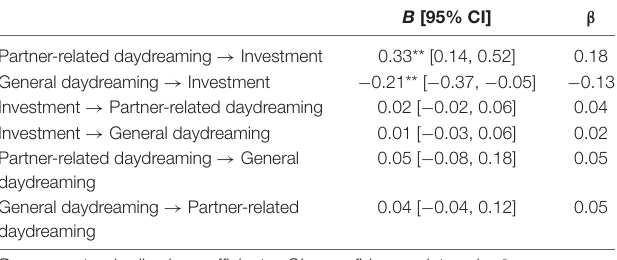
B = unstandardized coefficient. CI, confidence interval. β = average standardized